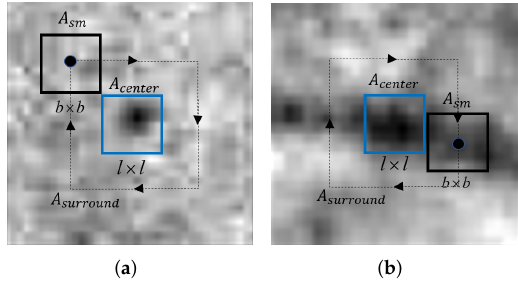
Figure 5. Examplesof candidate images. ( a ) Candidate image containing an MA. ( b ) Candidate image containing a vessel.